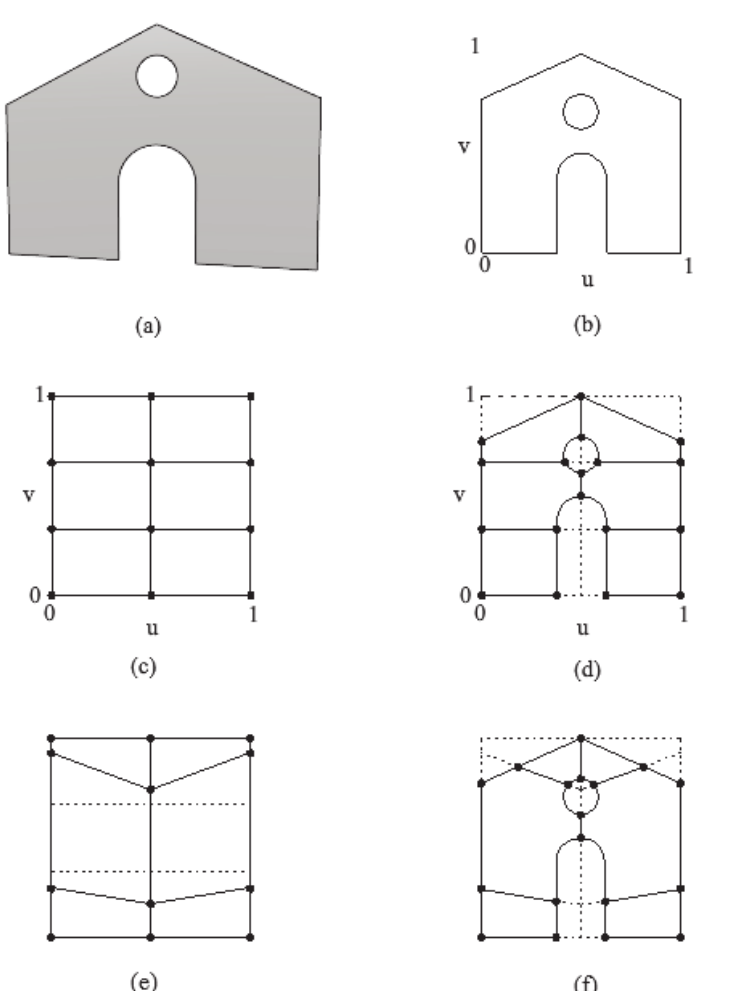
Figure 2: (a) NURBS model of masonry wall with openings. (b) Counter-image I w of the NURBS surface in the parameters space u-v .